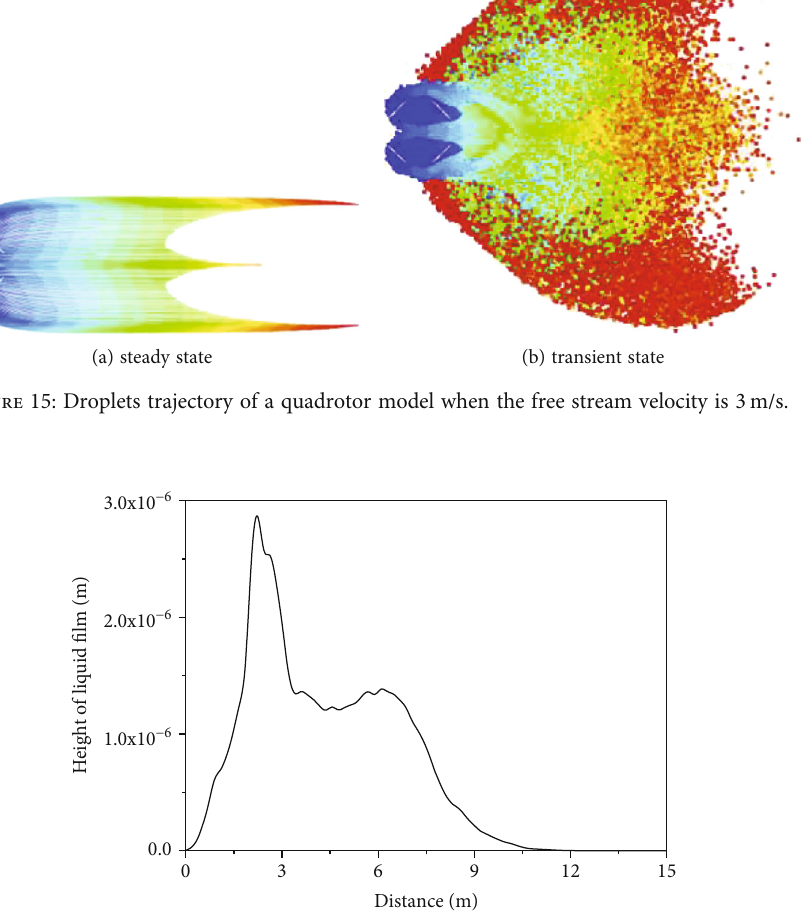
Figure 16: The droplet distribution of quadrotor model when free stream velocity is 3 m/s.